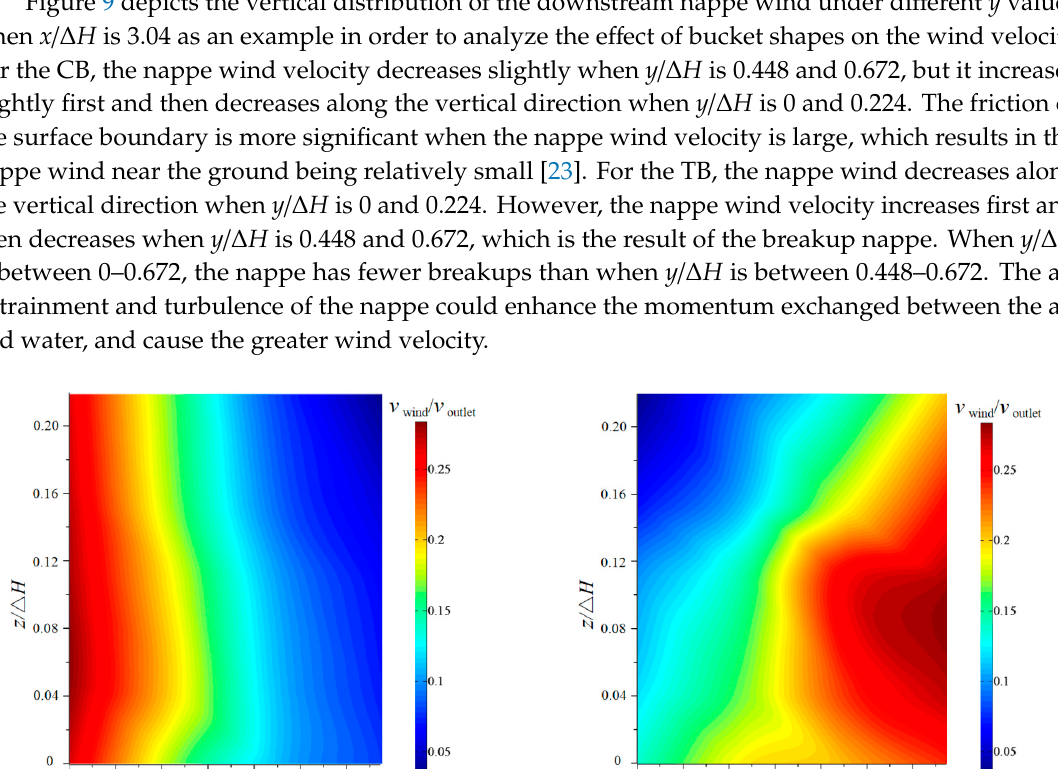
Figure 8. Vertical distribution of velocity of the nappe wind ( y/ Δ H =0): (a) CB, and (b) TB.